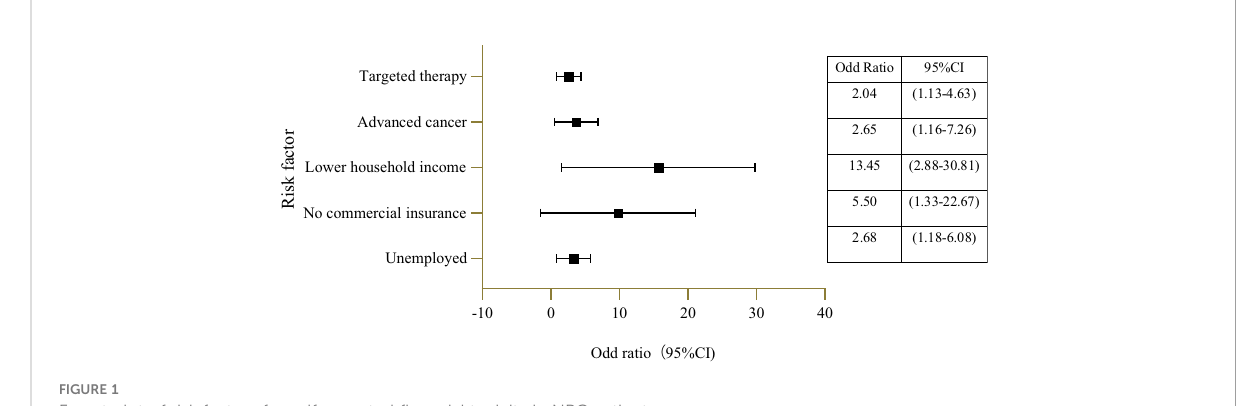
FIGURE 1 Forest plot of risk factors for self-reported fi nancial toxicity in NPC patients.